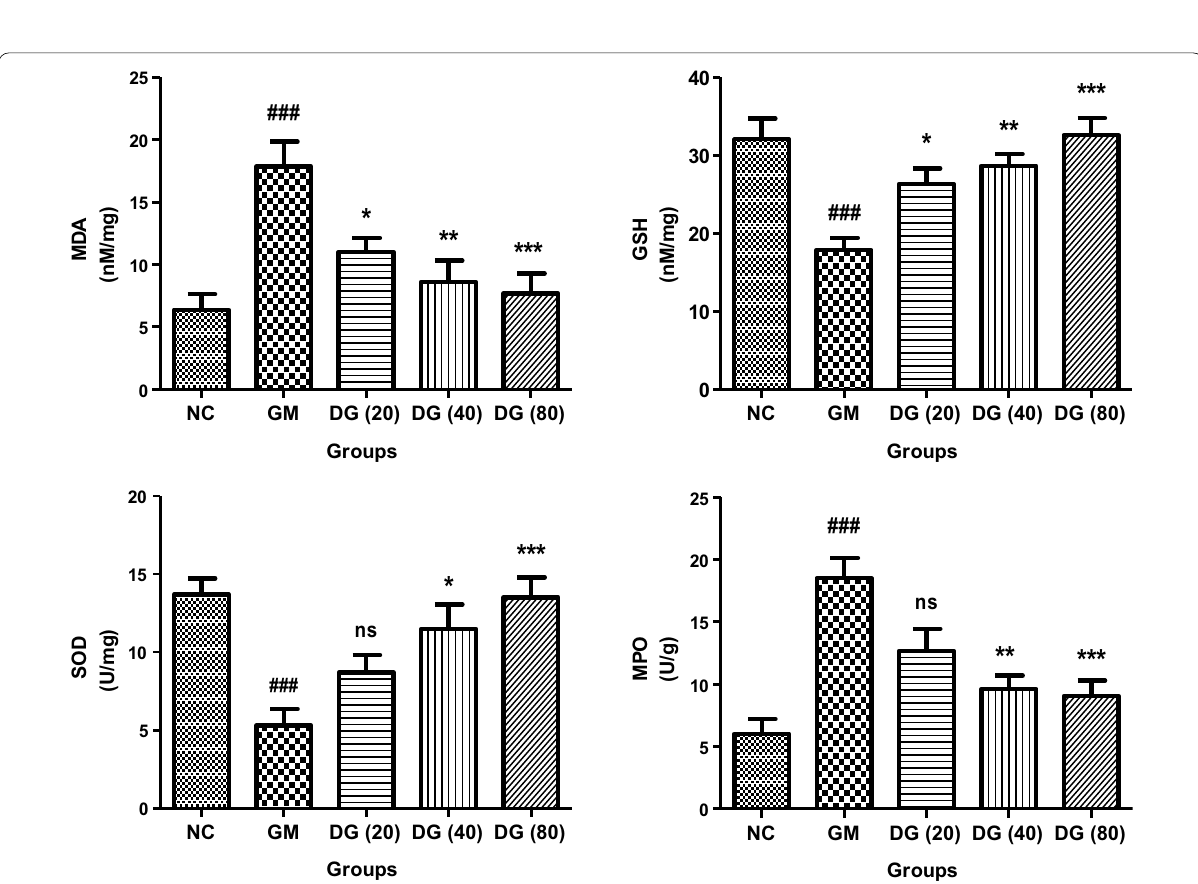
Fig. 6 Effect of DG on MDA, GSH, SOD and MPO levels in GM induced renal damage in rats. Values expressed as Mean compared to NC rats and * p < 0.05, ** p < 0.01, *** p < 0.001 as compared to GM